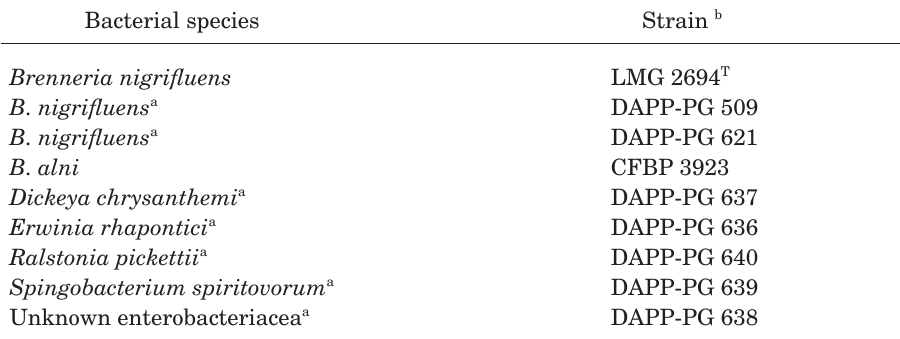
Table 1. List of bacterial strains used in the study. Bacterial